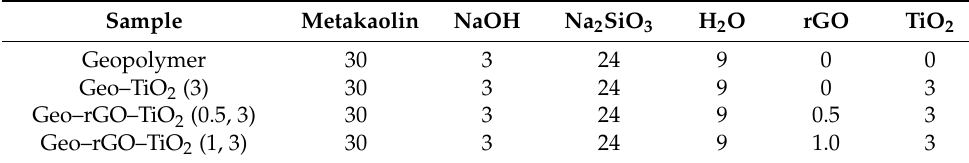
Table 1. Compositions of the starting materials for nanocomposite Geo–rGO–TiO 2 , in gram. Sample